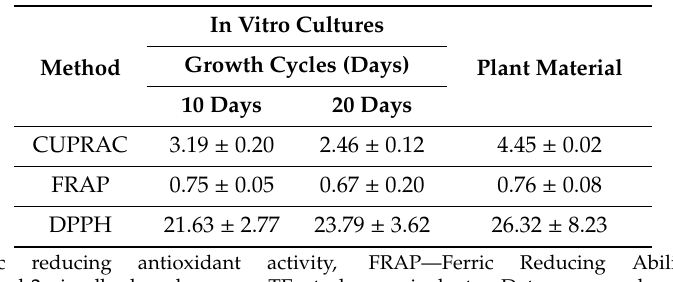
Table 4. Antioxidant potential estimated by CUPRAC, FRAP and DPPH methods (expressed in mmol TE / 100 g DW ± SD) in N. o ffi cinale extracts from bioreactor microshoot cultures and from the herb of the parent